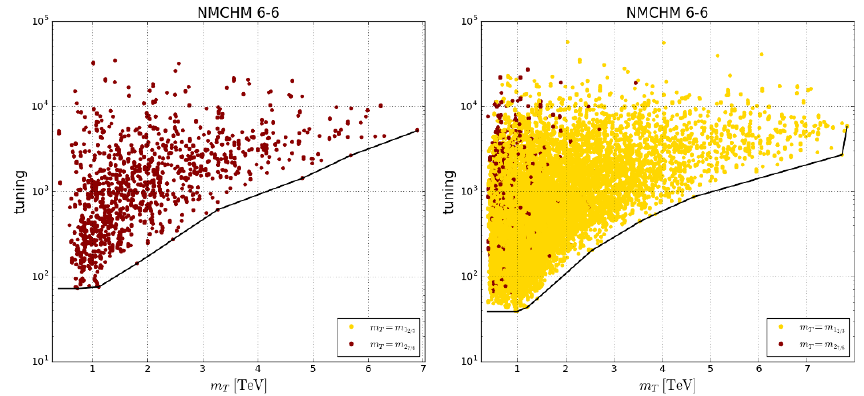
Figure 16. Top partner masses vs. full tuning, broken into region 1 (left) and region 2 (right), as de(cid:12)ned by equation